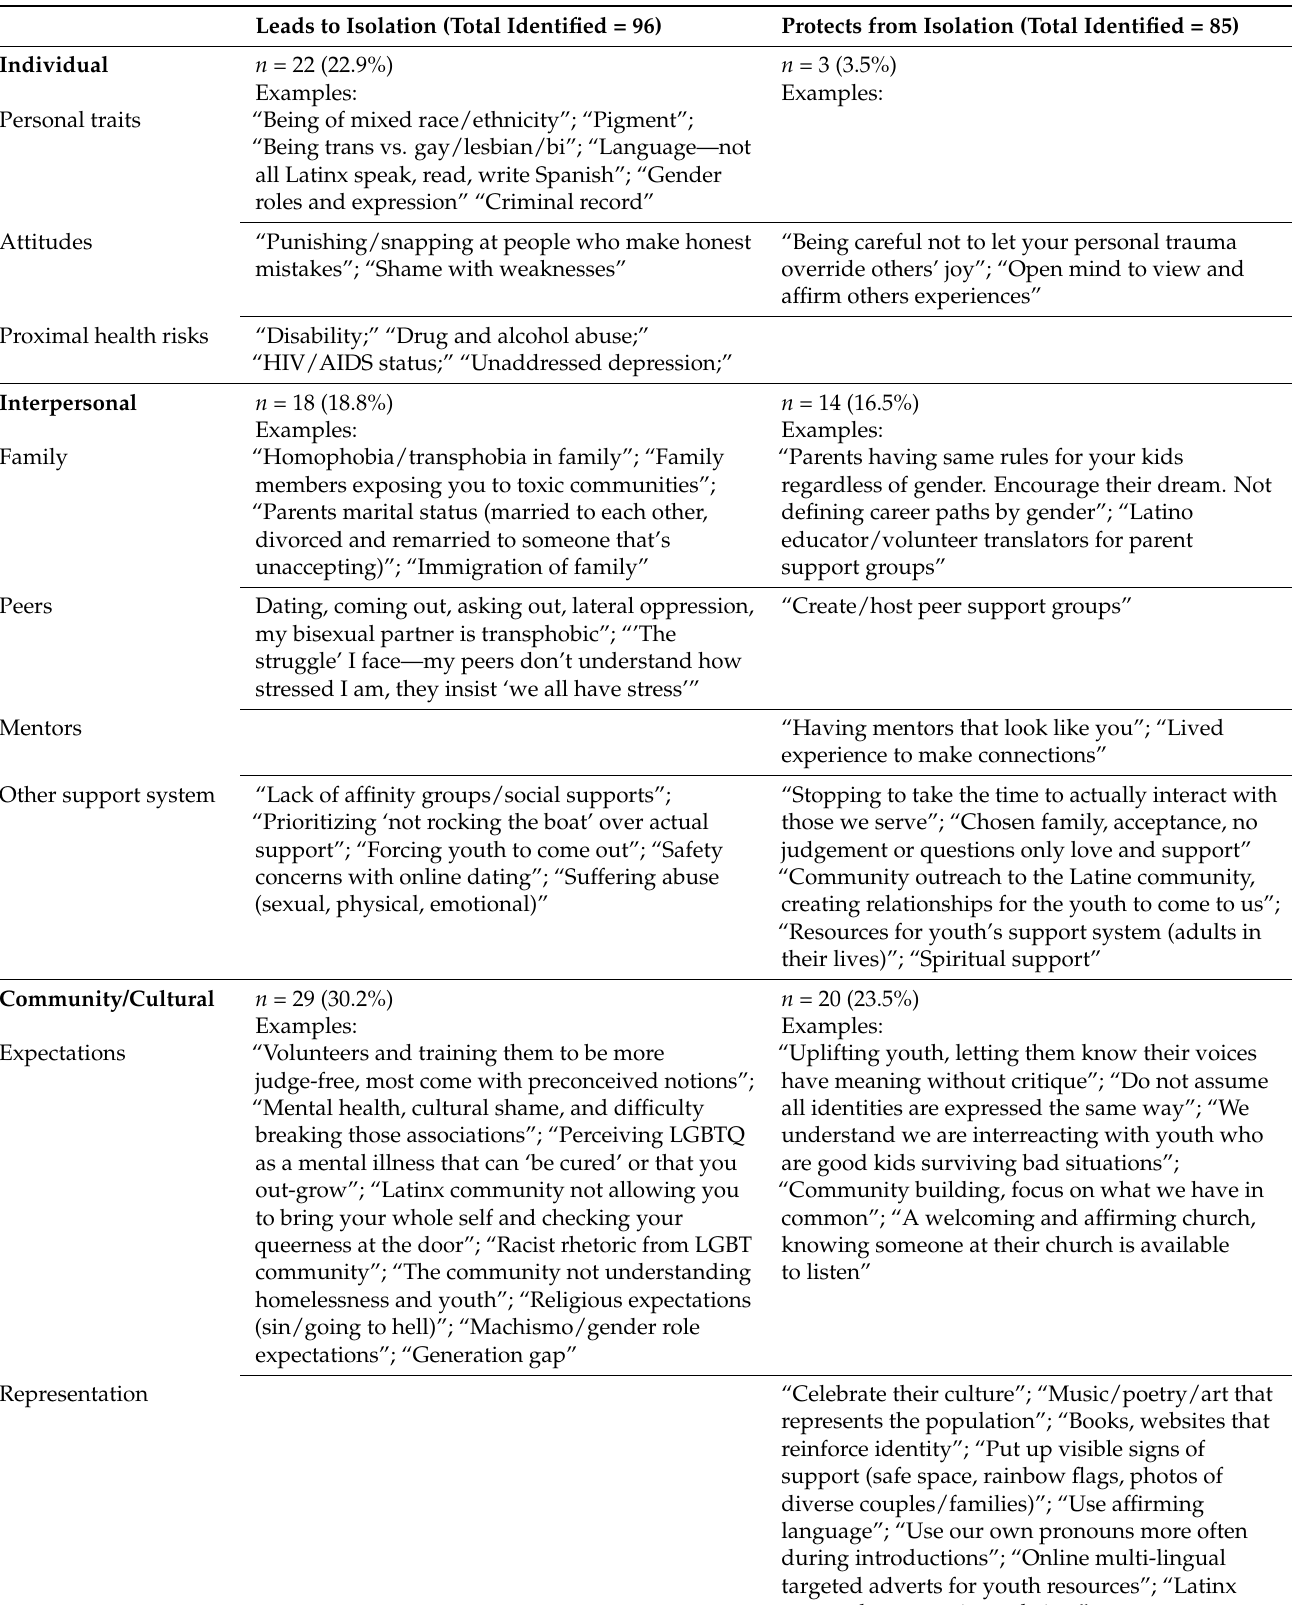
Table 5. Health and Social Service Providers’ Perspectives on Social